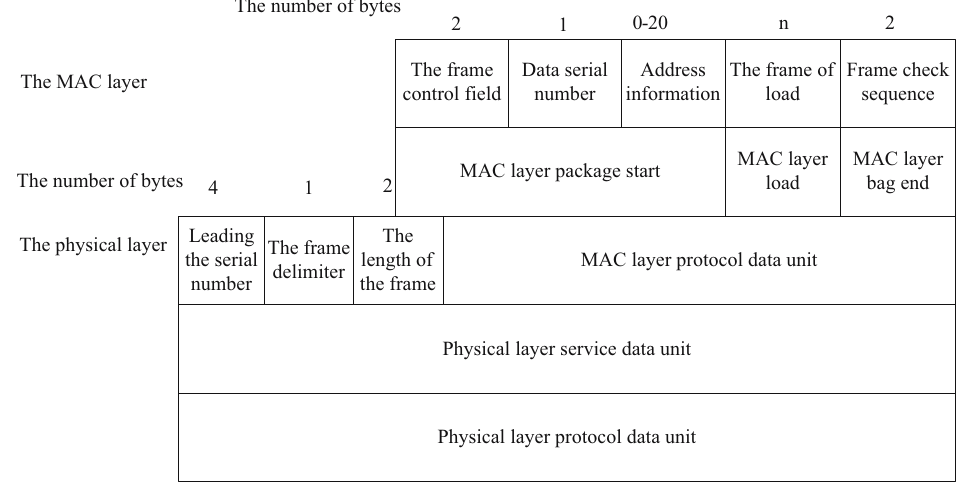
Figure 6: Format of transmission protocol